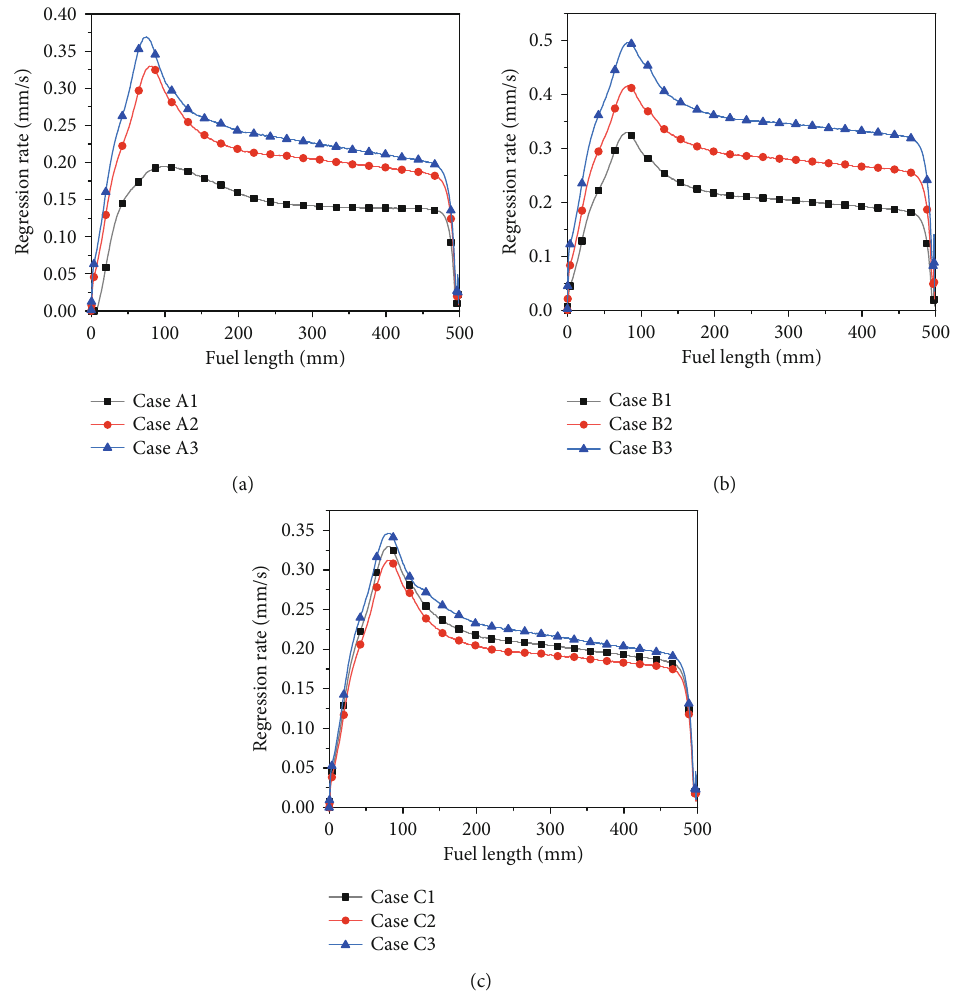
Figure 11: Pro fi les of the local regression